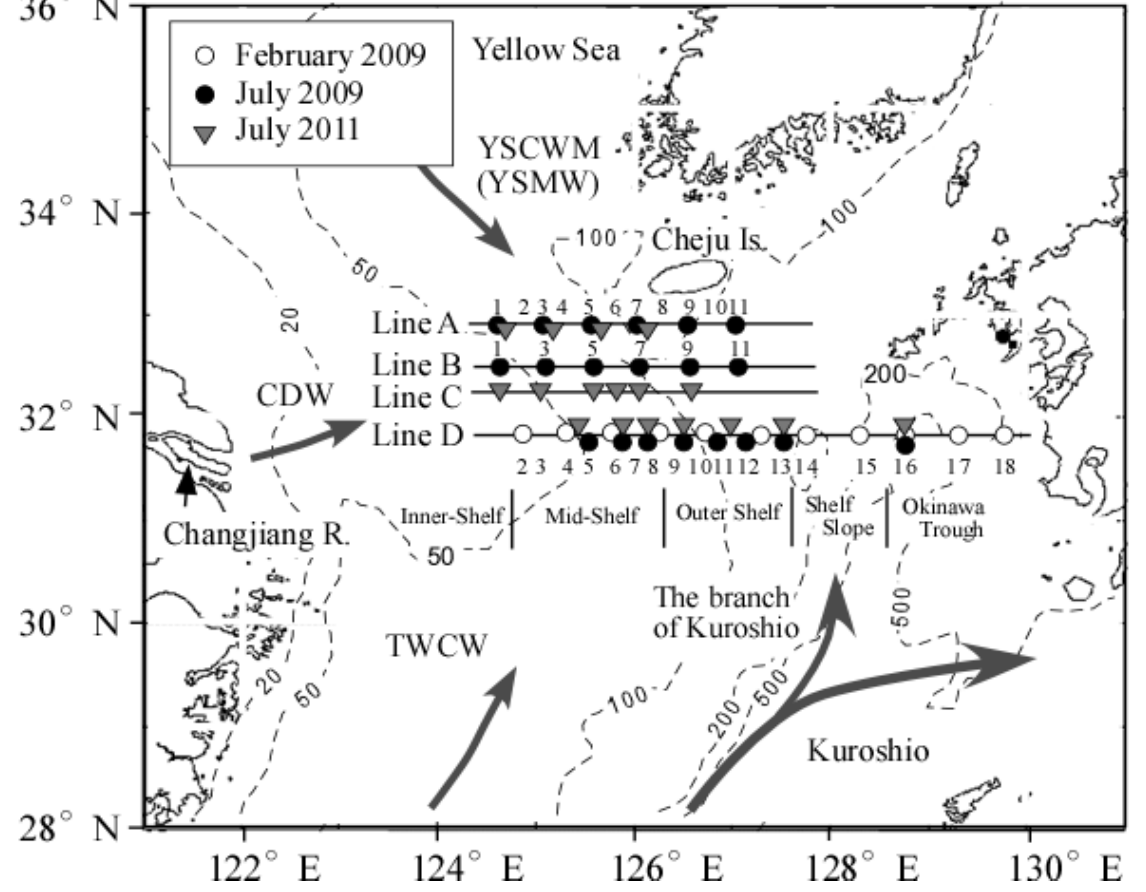
Fig. 1. Map of East China Sea showing the sampling stations in February and July 2009 and July 2011. A schematic image of the Kuroshio Current, Taiwan Warm Current Water (TWCW), Yellow Sea Cold Water Mass (YSCWM) and Changjiang Diluted Water (CDW) during summer and Yellow Sea Mixed Water (YSMW) during winter is also shown. The dashed lines indicate the